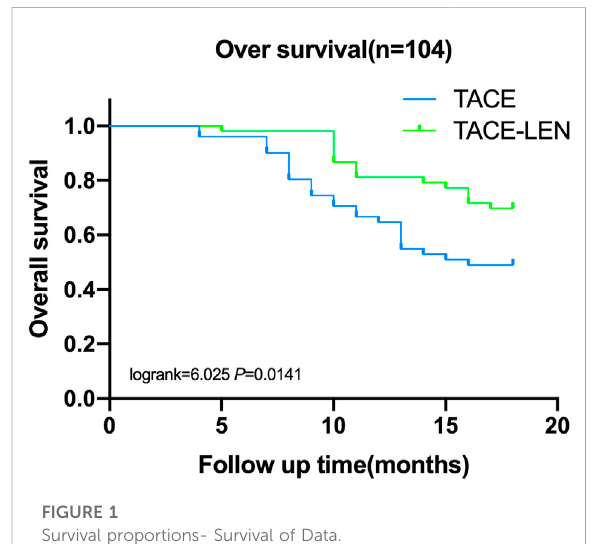
FIGURE 1 Survival proportions- Survival of Data.